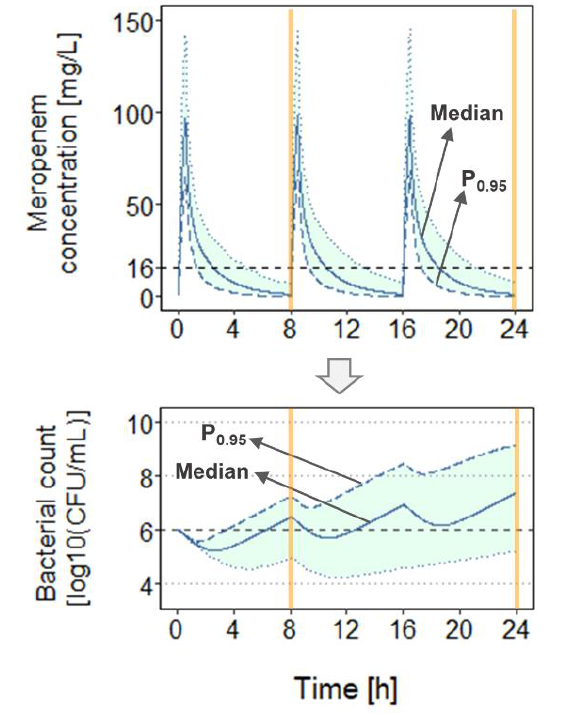
Figure 3. PKPD model-based output assessed for each scenario, exemplified by the default adult infected population (Li et al. [21]) and a 0.5h TDD6000mg (2000 mg every 8 h) dosing regimen. Total bacterial load (B tot ) and f T >MIC (time that unbound meropenem concentrations exceed the minimum inhibitory concentration; here: MIC = 16 mg/L) were assessed at 8 h and at 24 h after start of antibiotic treatment. P 0.95 : profile representing the 95th percentile in the population at a given time point; dashed lines mark the minimum inhibitory concentration of the ARU552 strain (upper panel) and the initial bacterial load/bacteriostasis (lower panel).